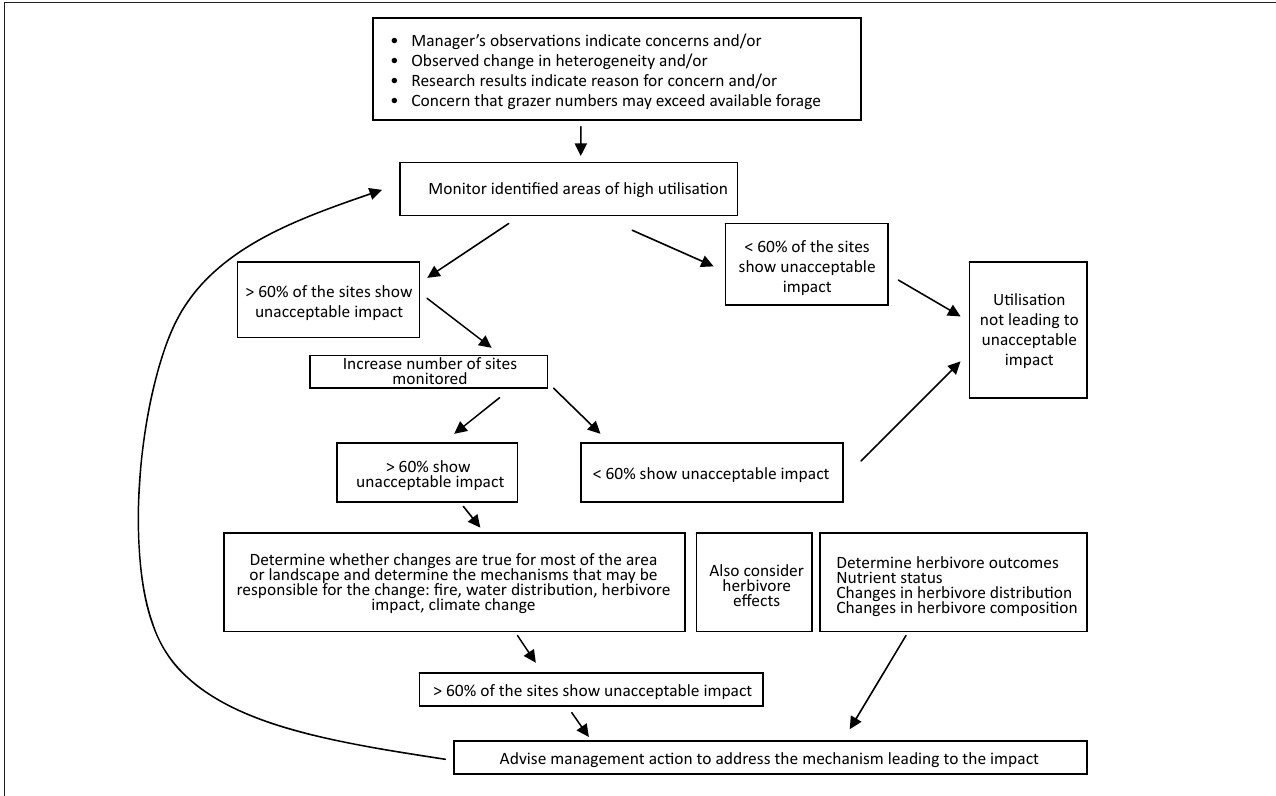
FIGURE 7: A framework for structuring a monitoring programme for detecting vegetation change and feedback mechanisms; thresholds set at 60% are illustrative only. Animal condition and nutritional